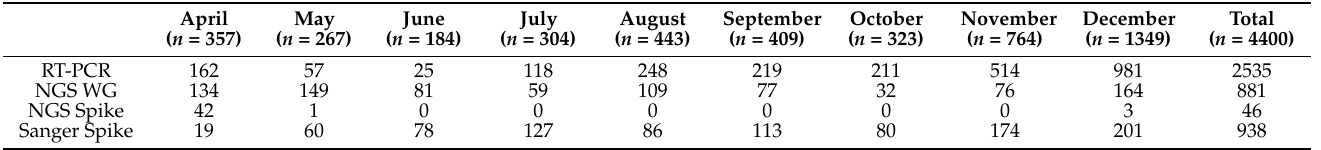
Table 1. Description of analysed